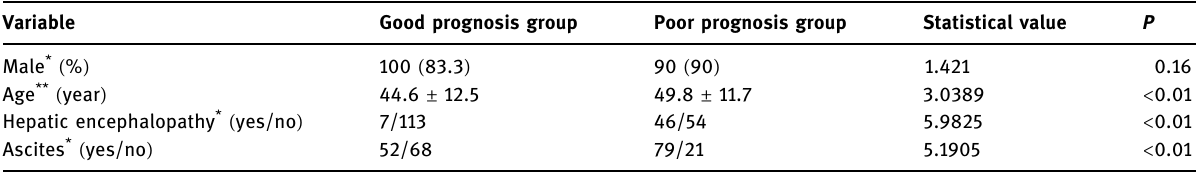
Table 1: Demographic information of patients